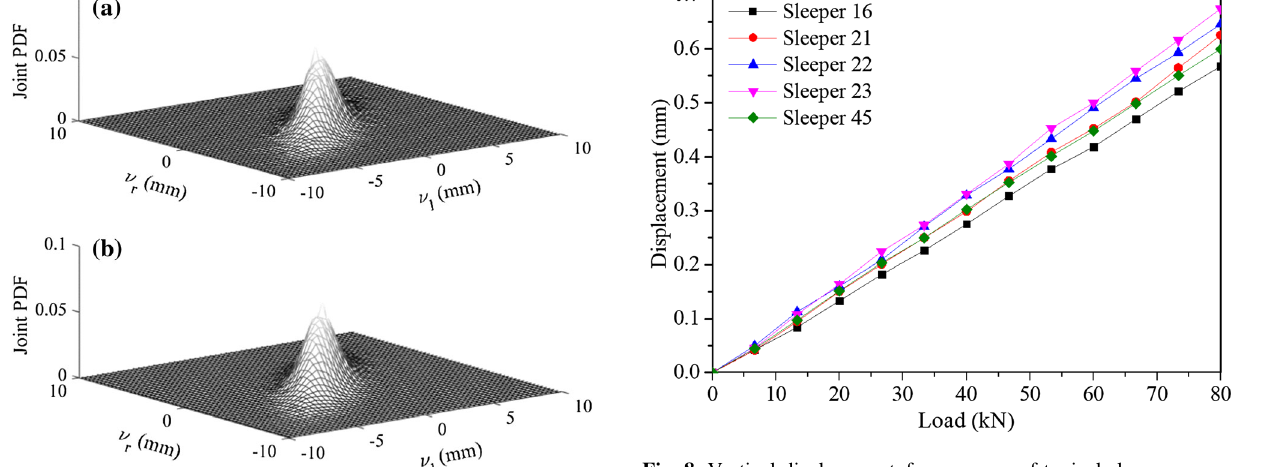
Fig. 8 Vertical displacement–force curves of typical sleepers